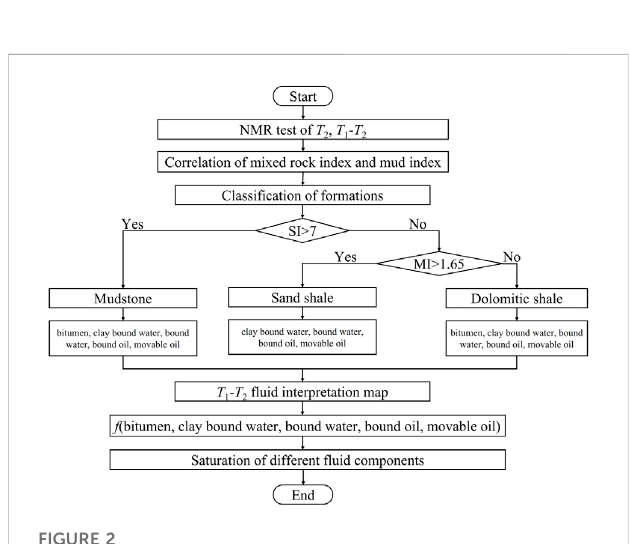
average of 15.6%. Illite content is 6% to 30%, with an average value of